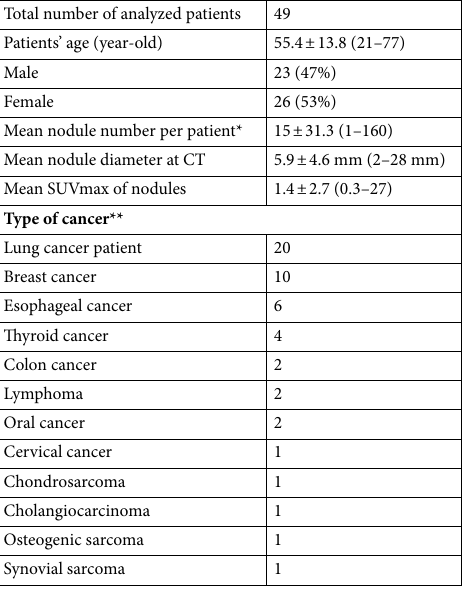
Table 2. Summary of patient information. SUVmax maximal standardized uptake value. *Number of lung nodules detected by chest CT after excluding nodules less than 2 mm. **One patient had both breast cancer and lung cancer; another patient had both thyroid cancer and lung cancer.